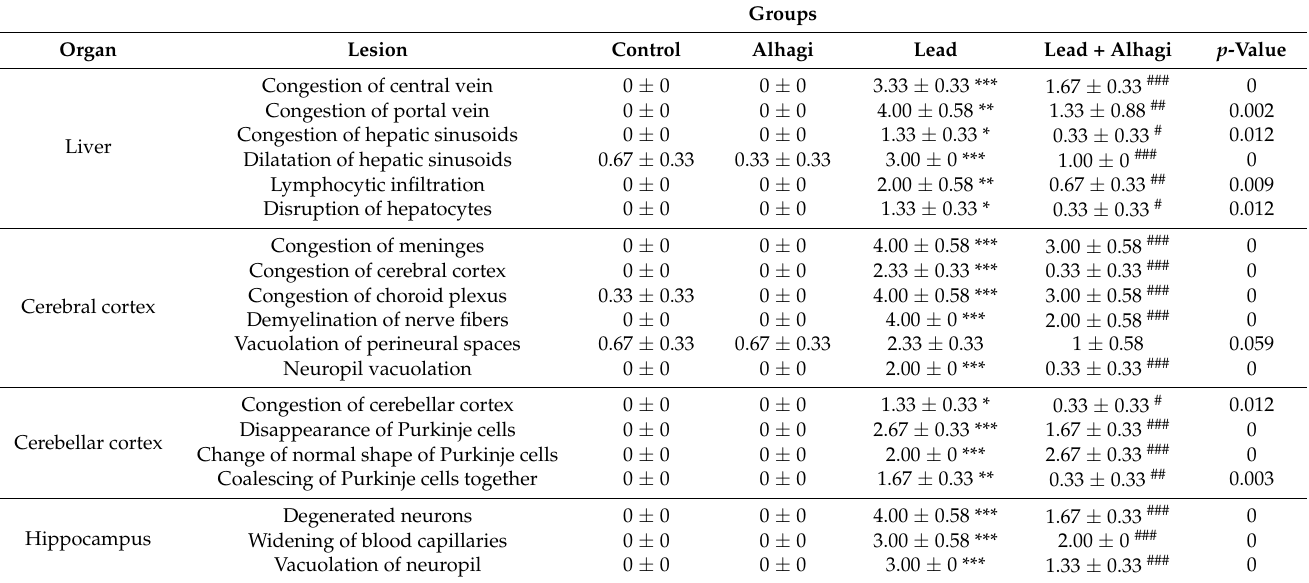
Table 5. Lesion scoring in the liver and brain tissues of rats in response to lead (100 mg/kg BW, orally) and A. maurorum extract (300 mg/kg BW, orally) treatments daily for 3 months.